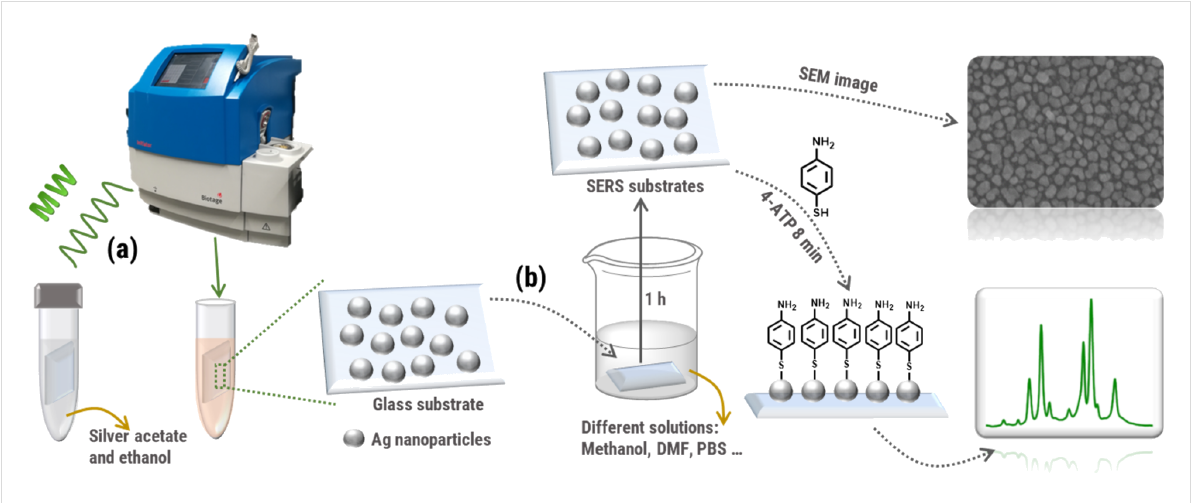
Figure 1: Schematic illustration of the microwave-assisted fabrication of SERS substrates (a) and the experimental pathway for investigating the stability of the SERS substrates in different organic solvents as well as in biological buffer solutions (b).